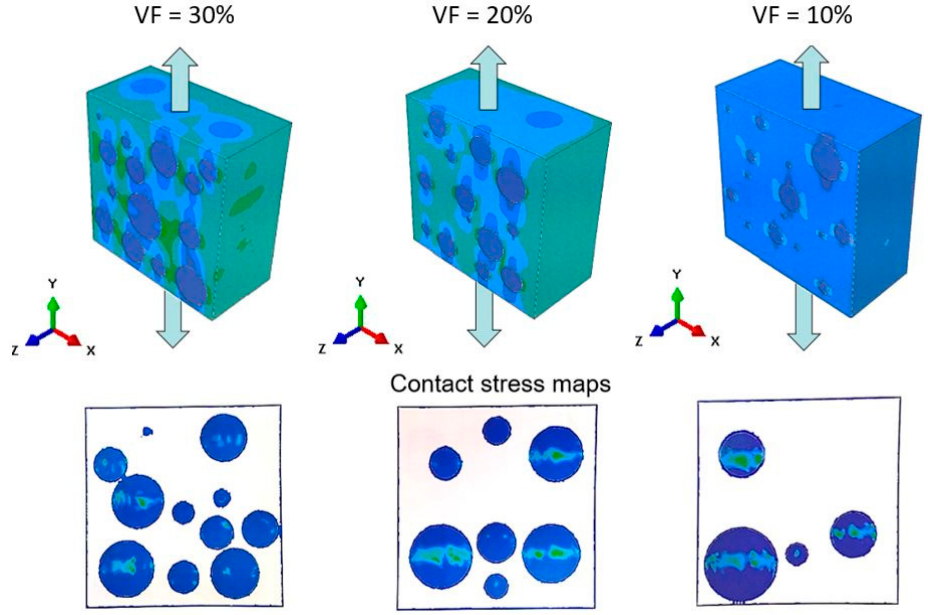
Figure 13. Contact-stress maps of RVE with nonbonded interface conditions for various particle volume fractions.